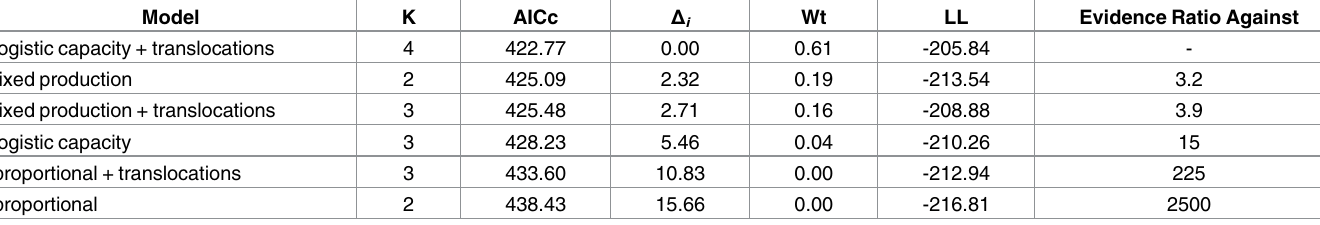
Table 7. Models for YOY abundance in October, ranked by